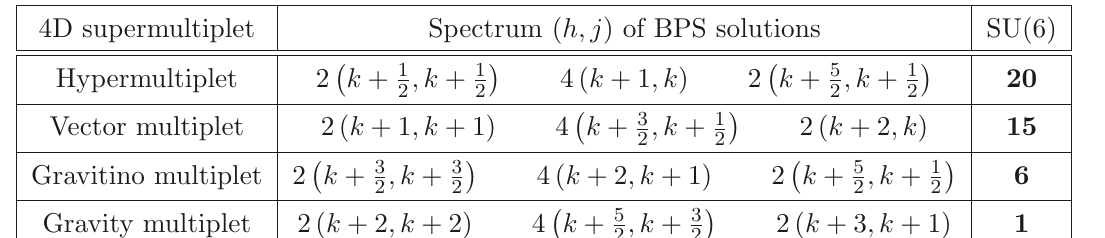
Table 6 . Bulk spectrum of BPS solutions. The integral label k the chiral primary and the remaining entries reflect the structure (5.1) of a short